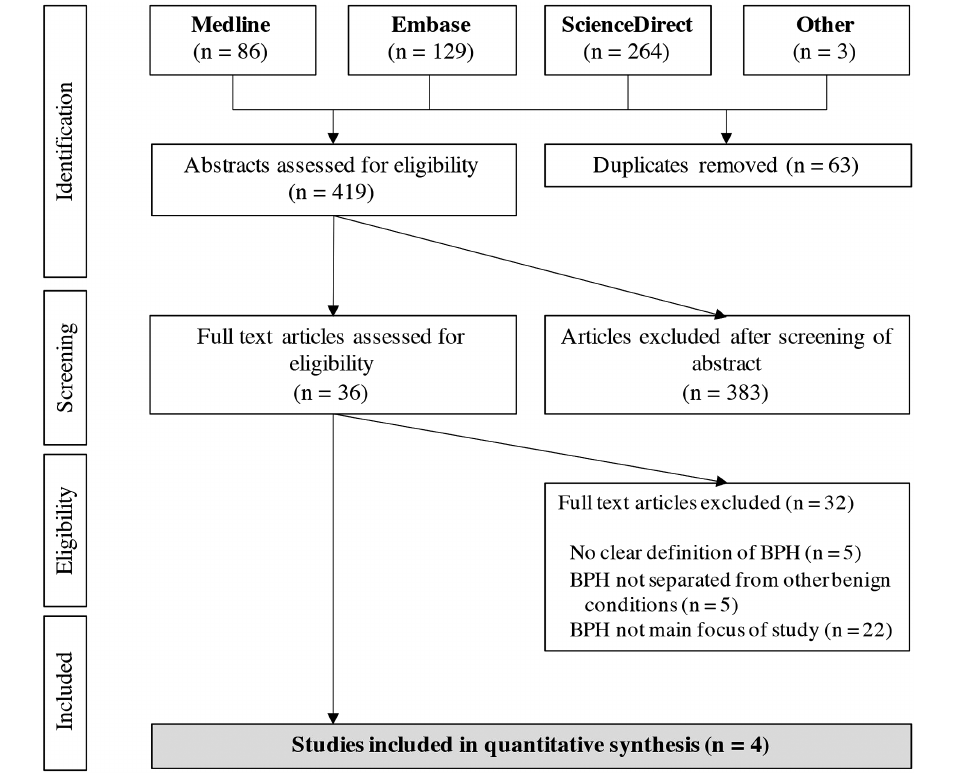
Figure 2. Preferred Reporting Items for Systematic Reviews and Meta-analyses flow